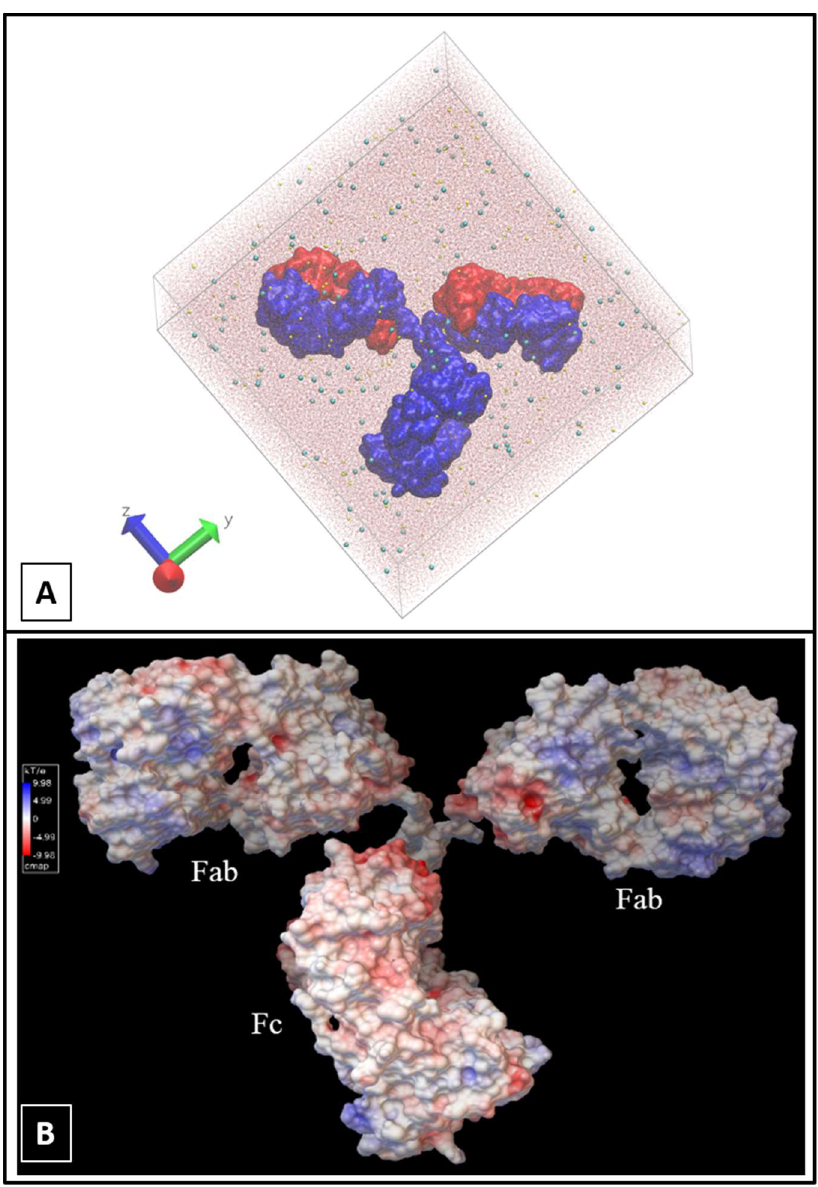
Figure 2. Antibody electrostatic potential and representation in primary simulation cell. ( A ) The explicit solvent (and ions) model illustrated by VMD [7]. The antibody is shown as a surface model; heavy chains are indicated in blue, while light chains are in red. Ions are shown by spheres: Cl − in yellow and Na + in cyan. The box is filled by water shown as transparent lines for clarity; ( B ) The surface-mapped electrostatic energy of IgG 2a was calculated and viewed by Python Molecule Viewer (PMV) v. 1.5.6 [34]. The map colour was coded as white: 0 kT/e, Blue: 9.98 kT/e, Red: −9.98 kT/e.